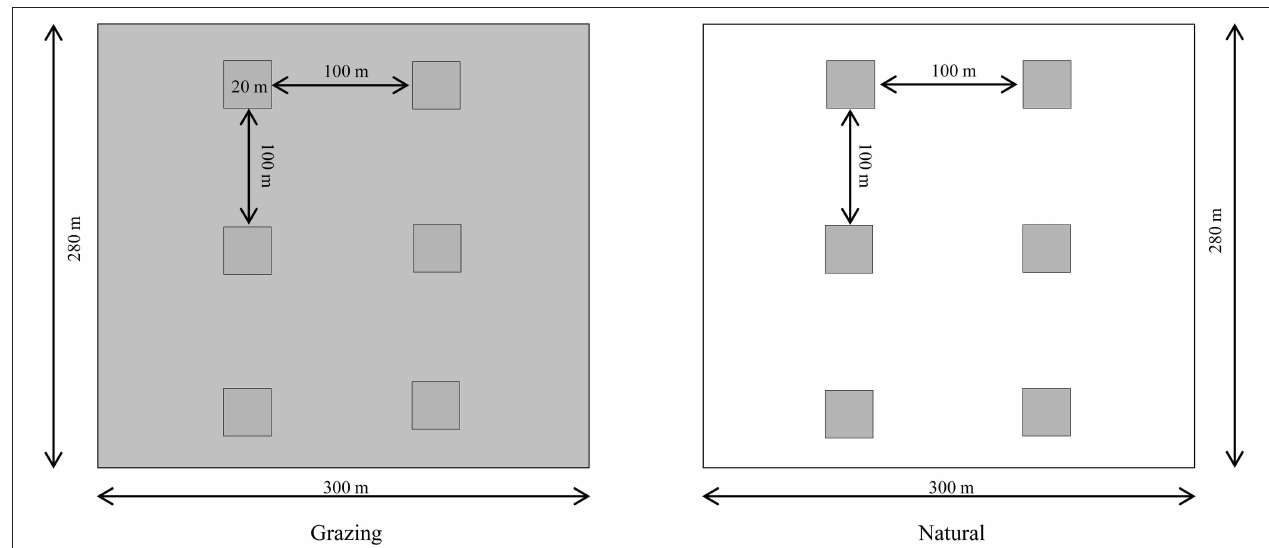
FIGURE 1 | Experimental design of the natural and grazing habitats (six plots per habitat) from 2016 to 2018 . In the grazing habitat, grazing experiments were performed (white area). The natural plots were surrounded by undisturbed vegetation (gray area). In each plot (20 × 20m), the average density of C. microphylla was 15 individuals per 100 m 2 , and the two habitats were separated by